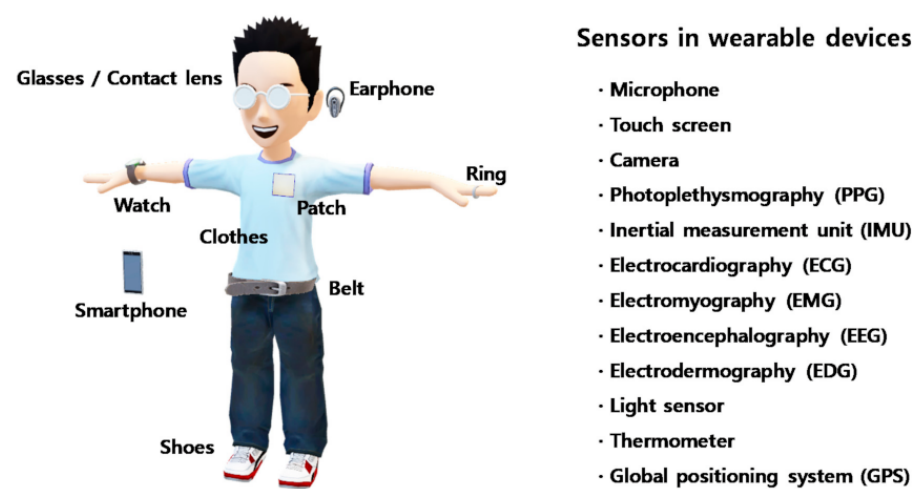
Figure 2. Various assistant devices and sensors that can be utilized for personalized healthcare. Microphones ana- lyze changes in vocal and sleep patterns, and the touch screen detects the function of fine motor controls. The inertial measurement unit and electromyography sensor analyze the motor performance of the body. Photoplethysmography, electrocardiography, electrodermography, the light sensor, and the thermometer monitor the physiological condition, and electroencephalography directly senses the brain